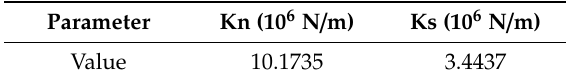
Table 9. Macro parameters of linear contact bond